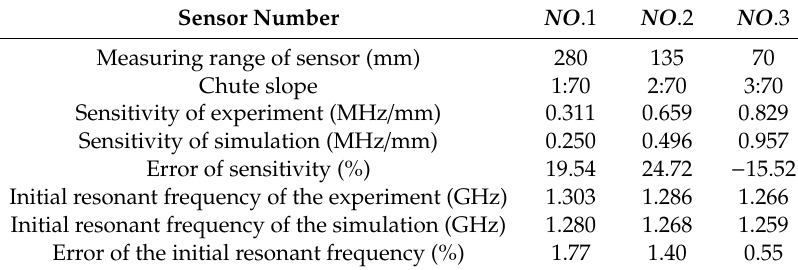
Table 2. Sensor experimental